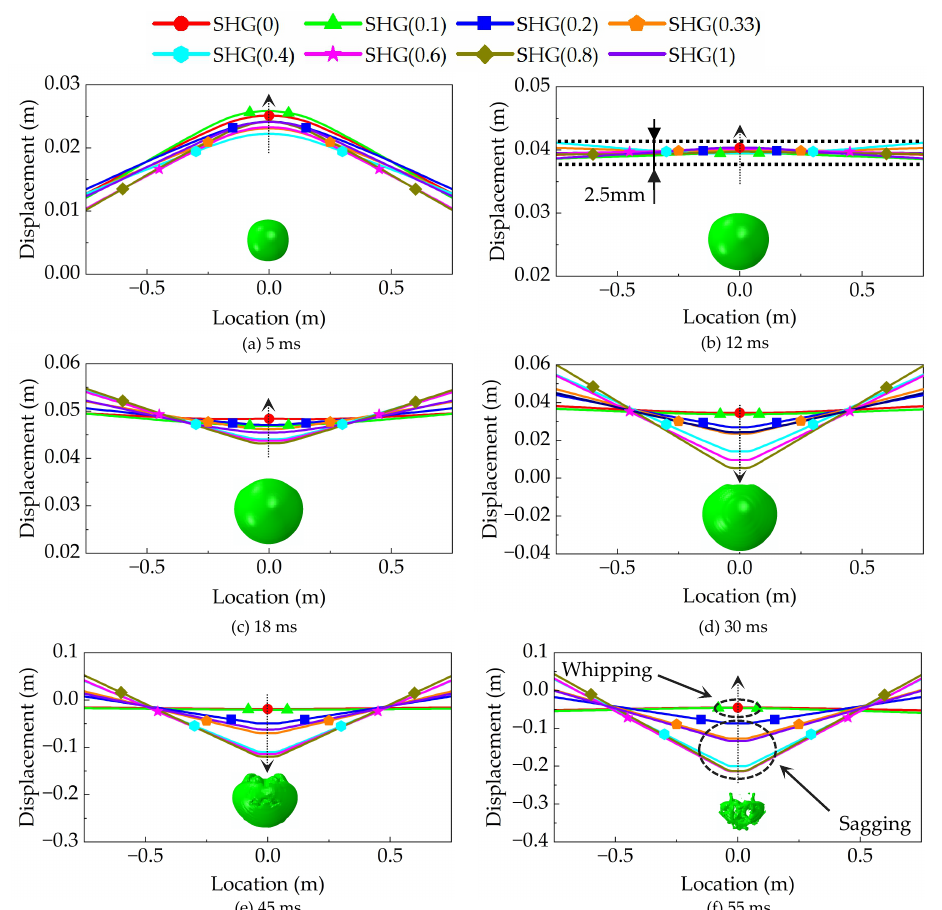
Figure 12. Contours of simplified hull girders: ( a ) 5 ms, ( b ) 12 ms, ( c ) 18 ms, ( d ) 30 ms, ( e ) 45 ms, ( f ) 55